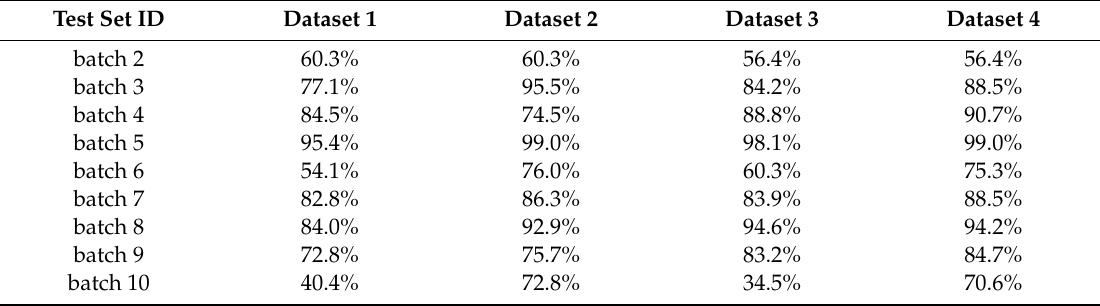
Table 6. Classification Accuracy of the SVM model under Four